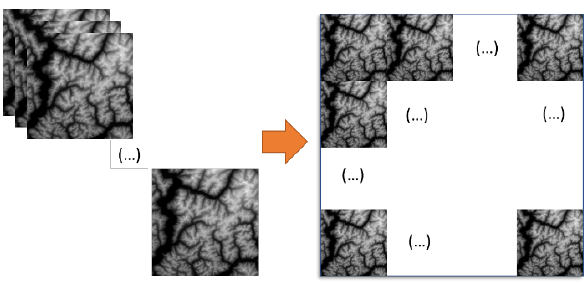
Figure 5. Sorting a 3D dataset into a 2D texture to improve